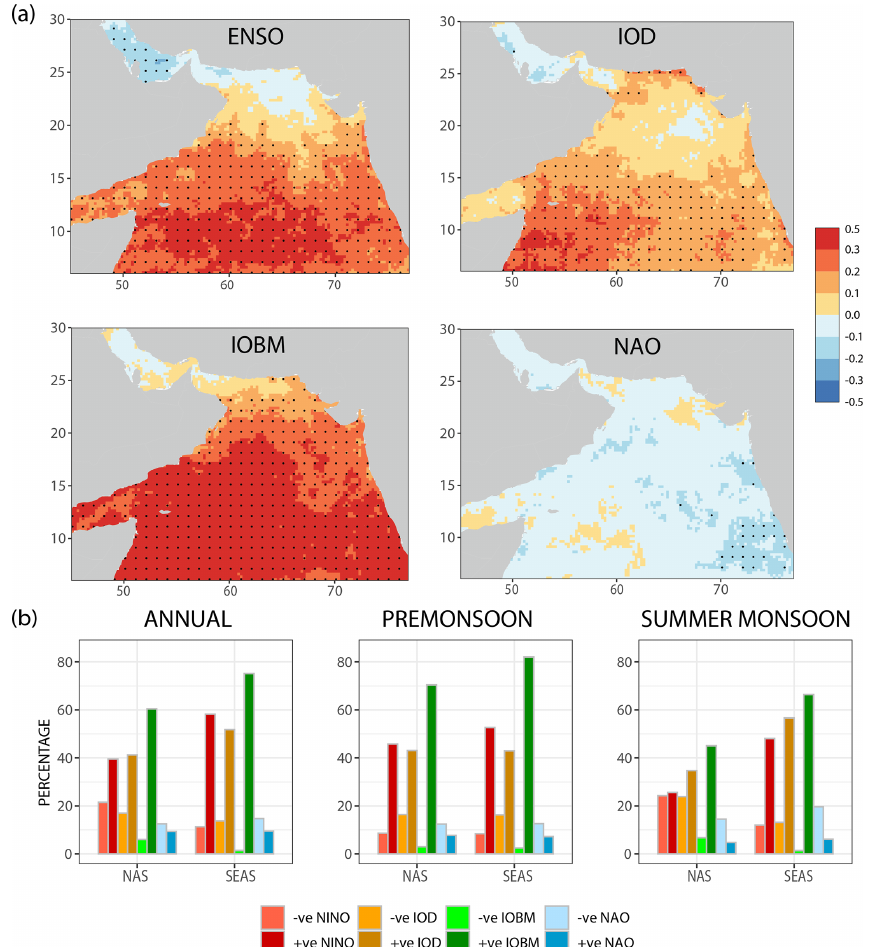
Figure 7. (a) Correlation between MHW days based on detrended SST ( ◦ C) and major climate modes. Stippling represents regions where correlation is 99% significant. (b) Percentage of co-existing days between observed heatwaves and climate modes for annual, pre-monsoon, and summer monsoon